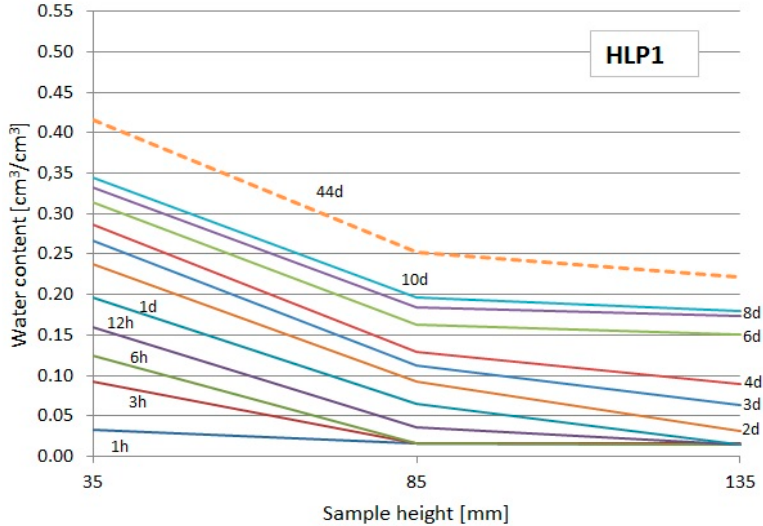
Figure 11. Moisture profiles obtained using the TDR measurement in particular intervals for the HLP1 composite.